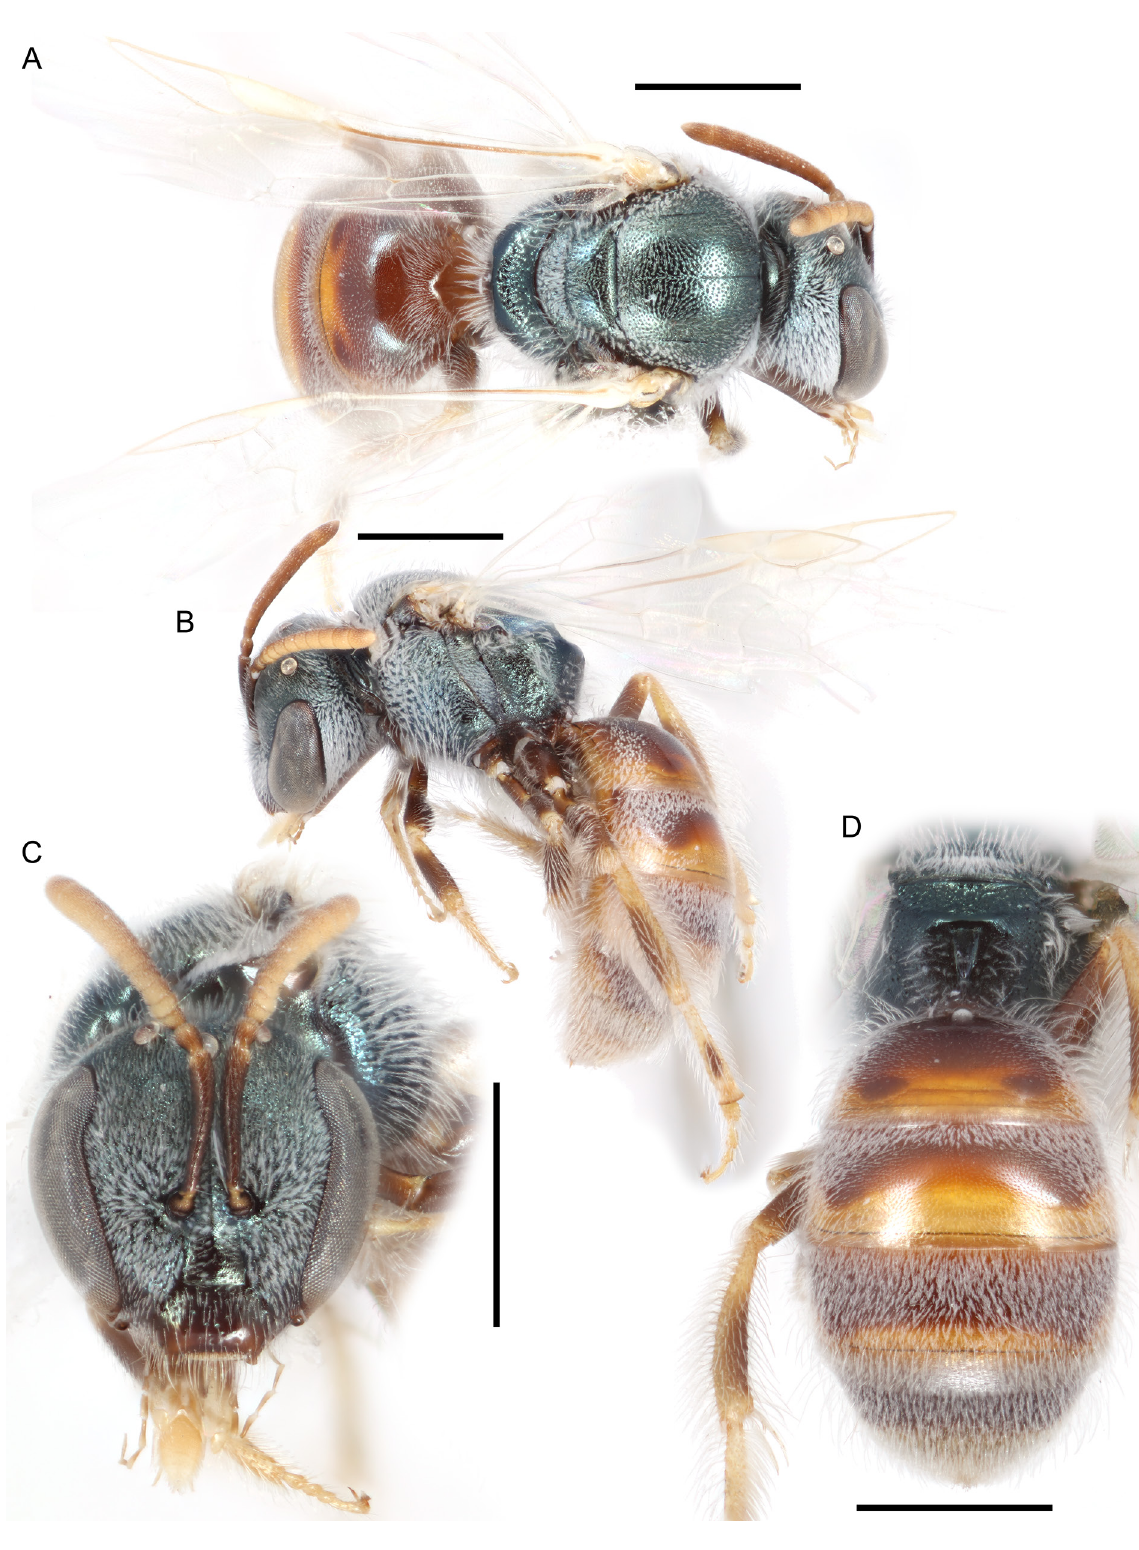
Fig. 75. Lasioglossum ( D. ) rufornatum sp. nov., ♀. A . Dorsal habitus. B . Lateral habitus. C . Face. D . Propodeum and metasoma. Scale bars: 1